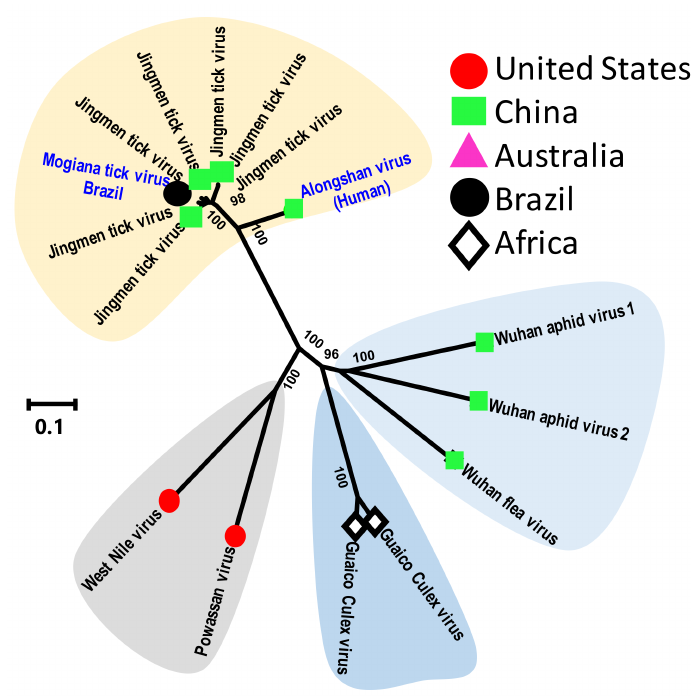
Figure 4. Phylogenetic relatedness based on the NS3-helicase protein of the JMTV-like viruses of ticks, aphids and mosquitoes and classical flaviviruses (Powassan and West Nile virus). This analysis involved 16 amino acid sequences. All ambiguous positions were removed for each sequence